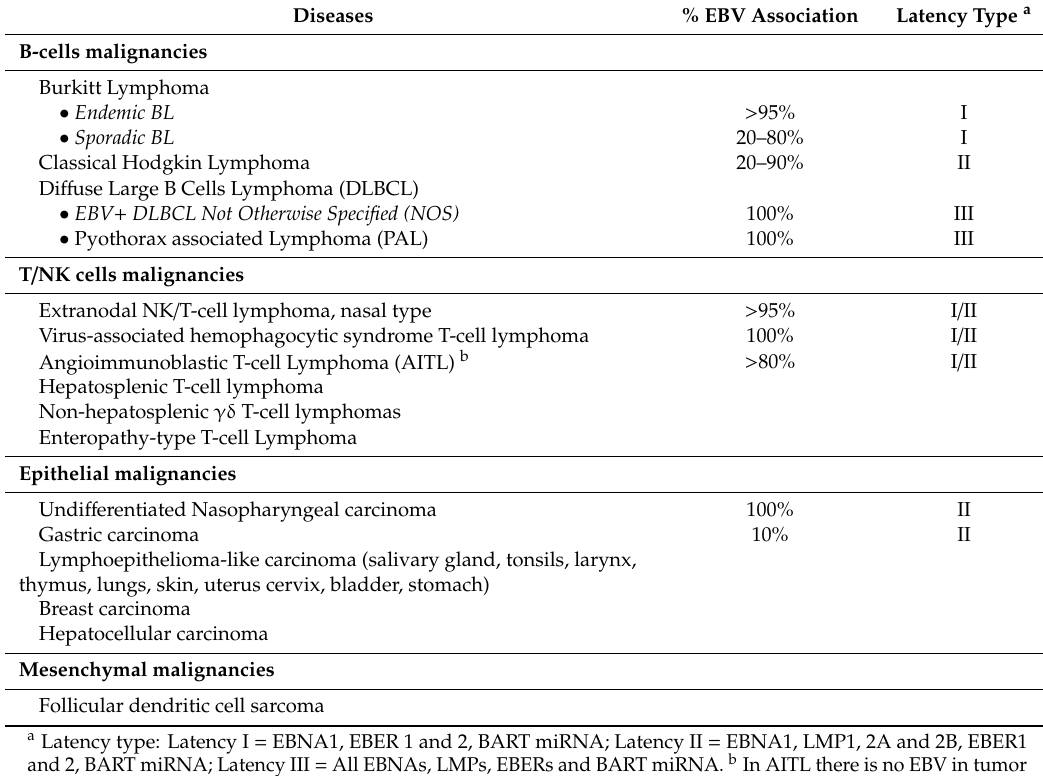
Table 1. EBV-associated malignancies in immunocompetent hosts and corresponding EBV association frequency and latent gene expression pattern.